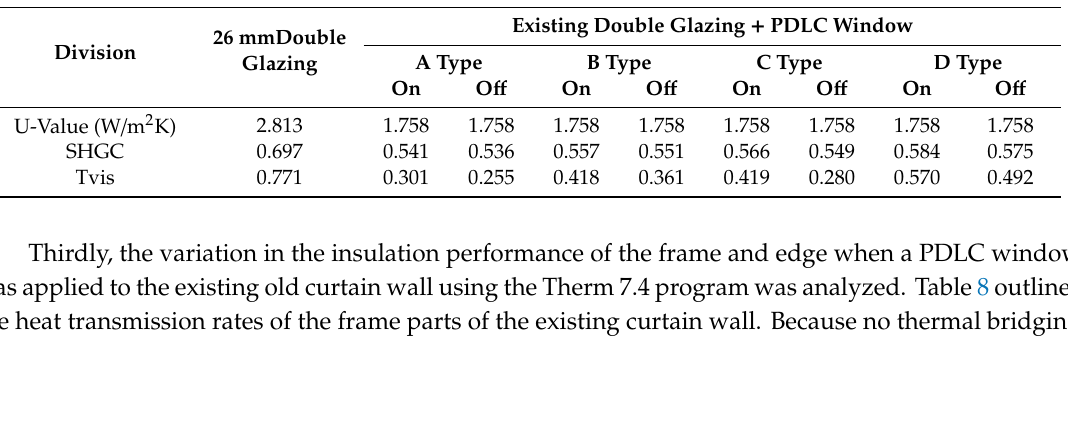
Table 7. Optical and thermal properties according to the addition of a PDLC laminated glass to the existing double